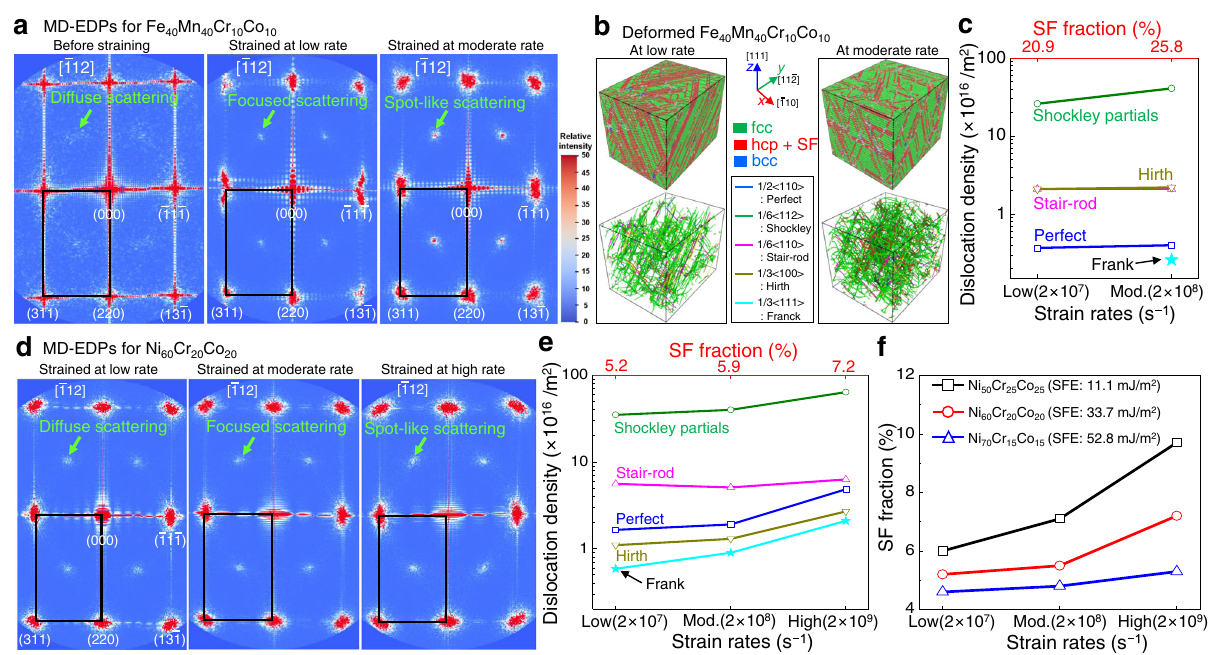
Fig. 6 | MD simulations for the origin of MSRO-generated extra scattering in non-equiatomic Fe 40 Mn 40 Cr 10 Co 10 (at%) HEA and non-equiatomic NiCrCo MEAs upon loading at 77K. a MD-EDPs for the interstitial-free FeMnCrCo struc- ture before and after straining. The [ (cid:1) 112] diffraction patterns for the structure before straining show MSRO-derived faint diffuse diffraction scattering at the ½{311} locations, while the relative intensity of MSRO-derived diffuse scattering increased with a higher strain rate. The colour scale (bottom right) de fi nes the relativeintensityofdiffractionspotsinarbitraryunits(blue:lowintensity;red:high intensity). b Corresponding cell structures strained at 77K under conditions of different strain rates, showing the distribution of deformation-induced SFs (stackingfaults:toppanel)anddislocationswithdifferentBurgersvectors(bottom panel). The dislocation distribution reveals that strong slip planarity was achieved at higher strain rates. There were no LRO precipitates in all cell structures. This af fi rms that spot-like scattering at the ½{311} locations in the MD-EDPs directly correlates with SFs and dislocations, but not with LRO structure. The strained cell